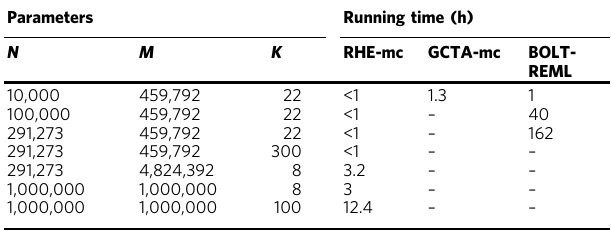
Here M , N , and K are the number of SNPs, individuals, and variance components, respectively. RHE-mc can run ef fi ciently even on datasets with one million individuals and SNPs as well